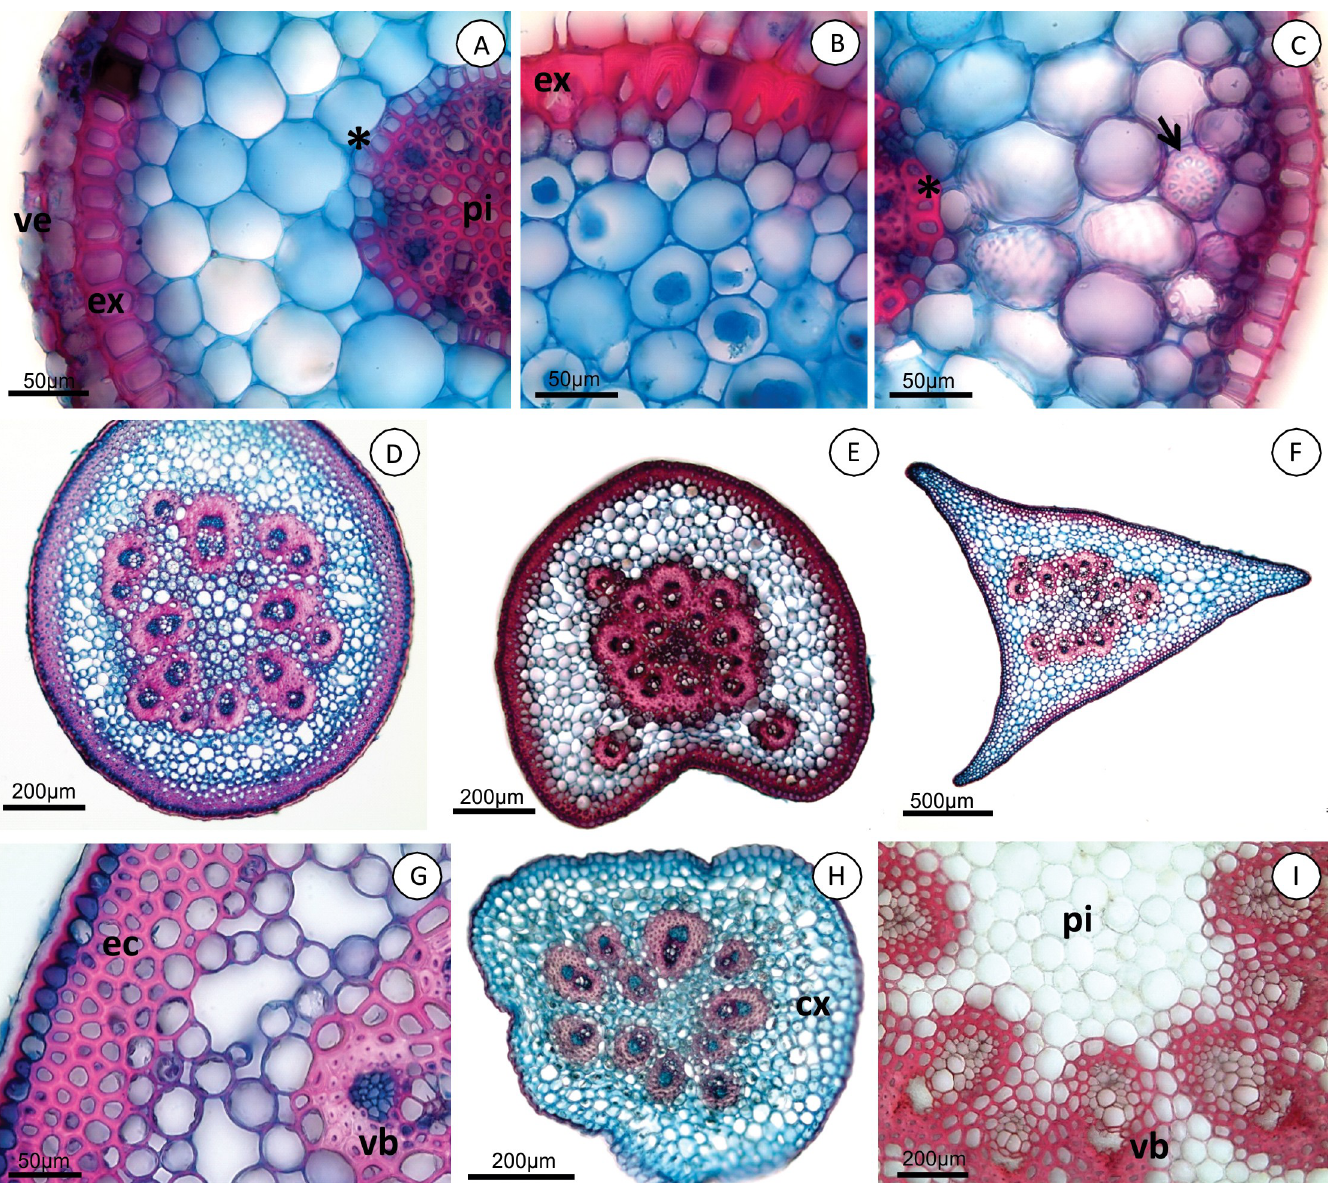
Fig 2. Acianthera root (A-C) and ramicaul (D-I) cross-sections. (A) Acianthera luteola . Bi-layered velamen (ve), exodermis with O-shaped wall thickening (ex) and endodermis with U-shaped thickening ( � ), pith cells (pi) with thickened lignified walls. (B) A . crepiniana , exodermis with inverted-U shaped thickening (ex). (C) A . fenestrata , cortex with reticulate idioblasts (arrow) and endodermis with O-shaped thickening ( � ). (D) Acianthera crepiniana , round ramicaul. (E) Acianthera saundersiana , round-sulcate ramicaul. (F) Acianthera luteola , triangular ramicaul. (G) Acianthera crepiniana , external cortex (ec) with sclerified cells. (H) Acianthera hystrix , ramicaul with parenchymatous cortex (cx). (I) Acianthera pubescens , ramicaul pith with unlignified cells (pi) after acidified phloroglucinol reaction. Vascular bundle (vb).